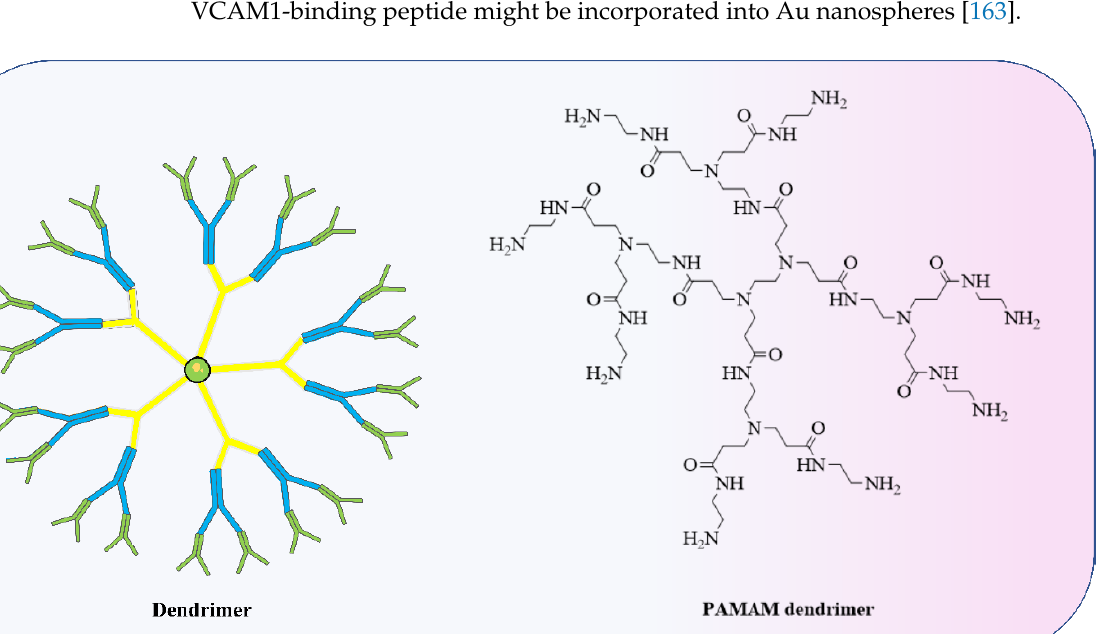
Figure 5. The anionic phosphodiester part of RNA is complexed by cationic amine groups (due to attachment of a proton) in polymeric nanoparticles and polymers based on poly(ethylenimine) (PEI), poly(l- lysine) (PLL), and poly(beta-amino ester) (PBAE). Polymers derived from poly(lactic- co-glycolic acid) (PLGA) are commonly modified to incorporate discrete cationic groups. Optimising multifunctional nanoparticles is difficult because they need a high load- ing efficiency, a hidden cationic domain to enable lysosomal escape, and dense, stable, targeting moieties. Vascular cell adhesion molecule 1 (VCAM1) was targeted by loading anti-miR-712 (1400 molecules, >95% loading efficiency) onto cationic lipoparticles (CCLs) coated with 5 mol% of peptide (VHPK). In vitro and in vivo studies confirmed disease- specific accumulation of anti-miR-712 in endothelial cells from inflamed mice aortas. With the help of VHPK-CCL-anti-miR-712, the endothelium ’ s metalloproteinase activity was suppressed by reducing the miR-712 expression that was increased by d-flow and restor- ing the expression of its target genes, TIMP3 and RECK. VHPK-CCLs transported anti- miR-712 to inflamed endothelium in pro-atherogenic d-flow areas. This may also be used in case of mimics, miRNA inhibitors, plasmids, siRNAs, and pharmaceuticals. VCAM1-